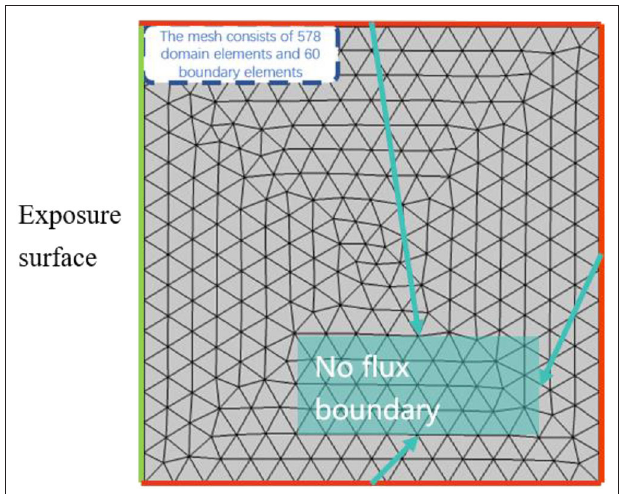
FIGURE 2 | Physical field control grid.